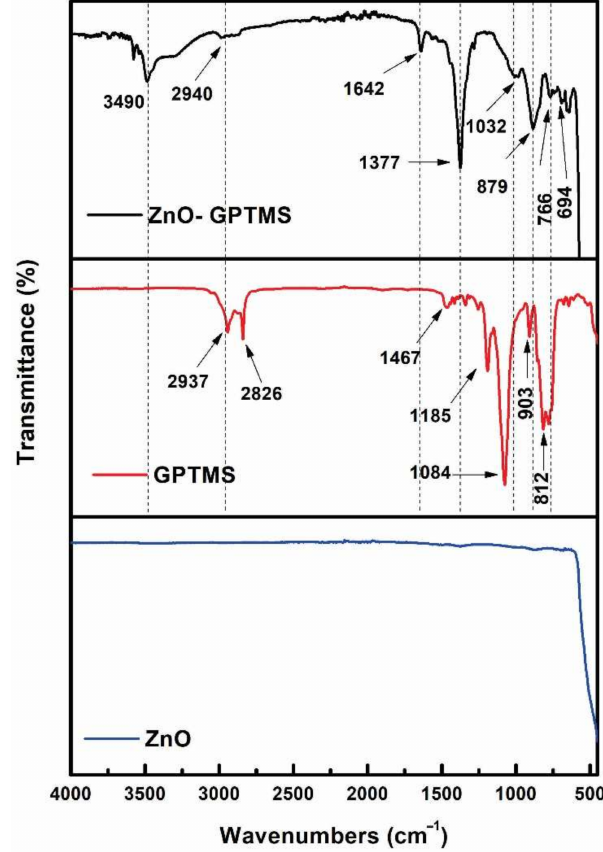
Figure 3. FTIR, ZnO-NPs, GPTMS, and ZnO-NPs-GPTMS spectra.